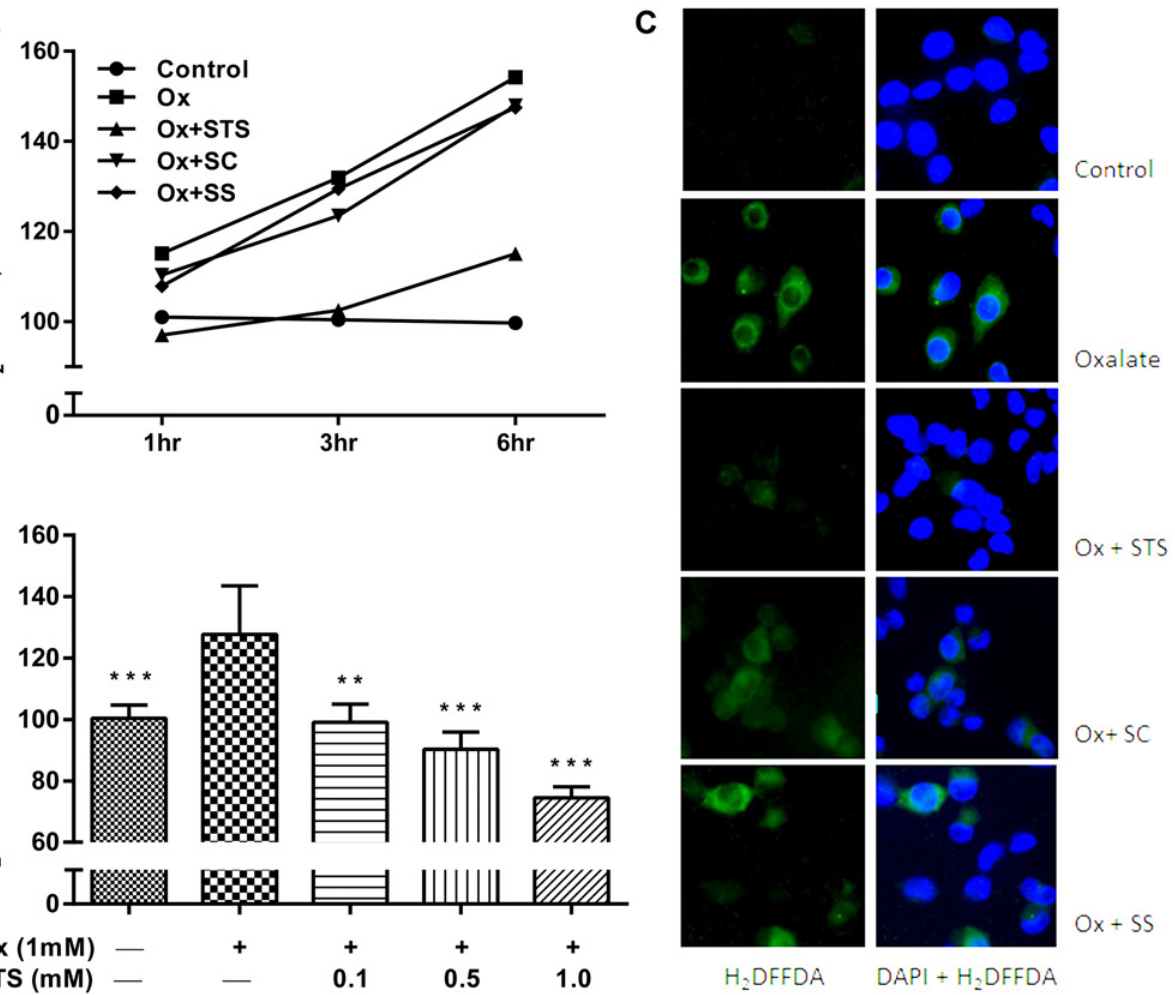
Fig 7. STS reduces intracellular oxidative stress. Oxidative stress was induced by exposure of proximal tubular LLC-PK1 cells towards 1 mM oxalate, and detected using the fluorescence dye H 2 DFFDA. (A) Fluorescence changes in untreated LLC-PK1 cells (Control), oxalate (Ox)-exposed LLC-PK1 cells (1 mM), and Ox+STS, Ox+SC and Ox+SS-exposed LLC-PK1 cells. STS largely protects LLC-PK1 cells against oxalate-induced oxidative stress. (B) Dose- dependent protection by STS against oxalate-induced ROS in LLC-PK1 cells. Data were analyzed by one-way analysis of variance (ANOVA) with Bonferroni ’ s multiple comparison. Asterisks ( * ) indicate statistically significant differences ( p < 0.05) with respect to oxalate-exposed cells. (C) H 2 DFFDA- and DAPI-fluorescence imaging of LLC-PK1 cells. The absence of green fluorescence in oxalate-exposed, STS-treated LLC-PK1 cells indicates the quenching of intracellular oxidative stress by STS. Control = 100% in (A) and (B). Significance levels are with reference to oxalate (Ox) group. The data are means ± SD from 8 values per group. * p < 0.05, ** p < 0.01, *** p <